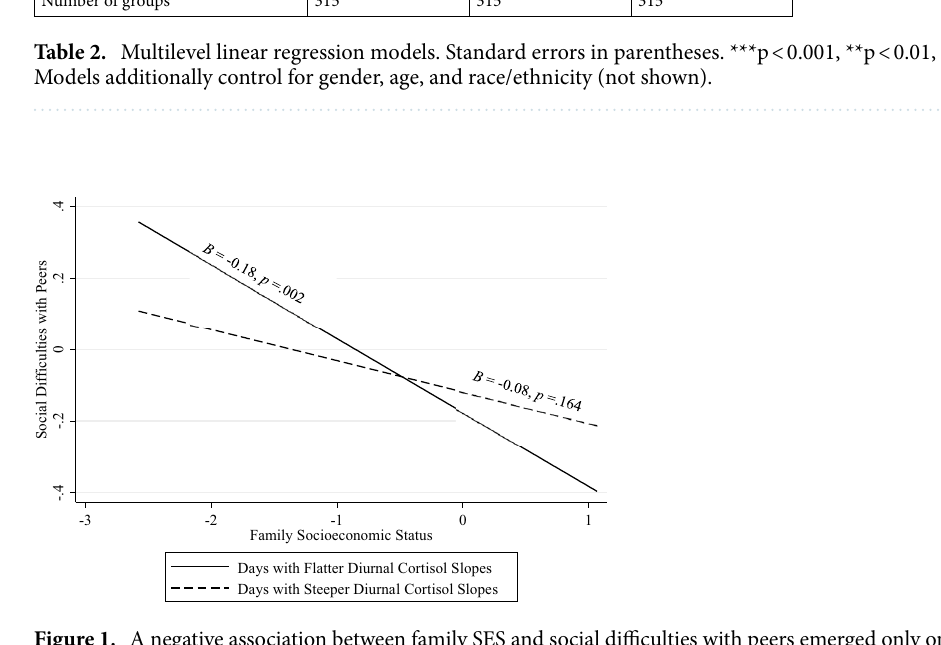
Figure 1. A negative association between family SES and social difficulties with peers emerged only on days that youth showed flatter diurnal cortisol slopes, a marker of daily biological sensitivity to context. In contrast, family SES was not related to social difficulties on days that youth showed steeper, declining diurnal cortisol